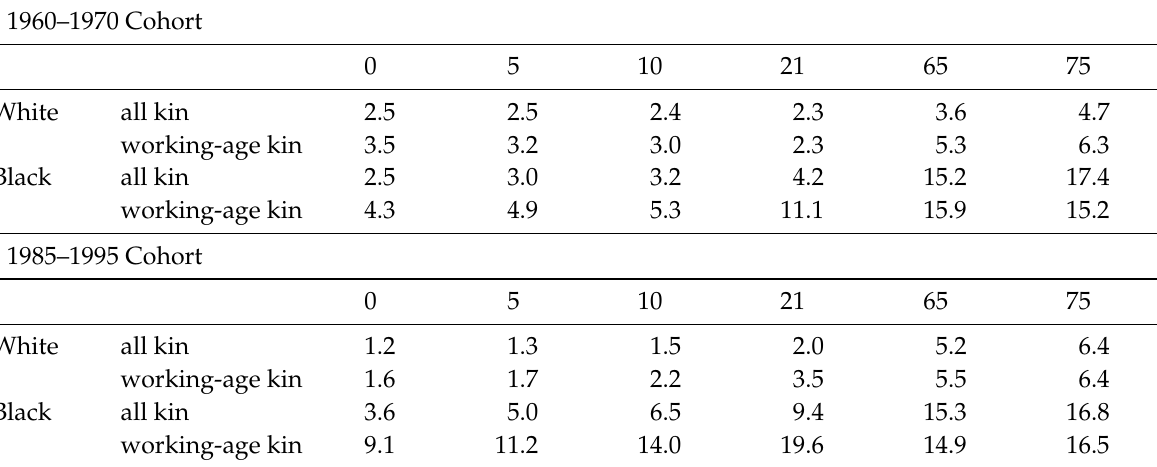
Table 1: Prevalence (in percents) of kin imprisonment by age, race, and type of kin for two cohorts. 1960–1970